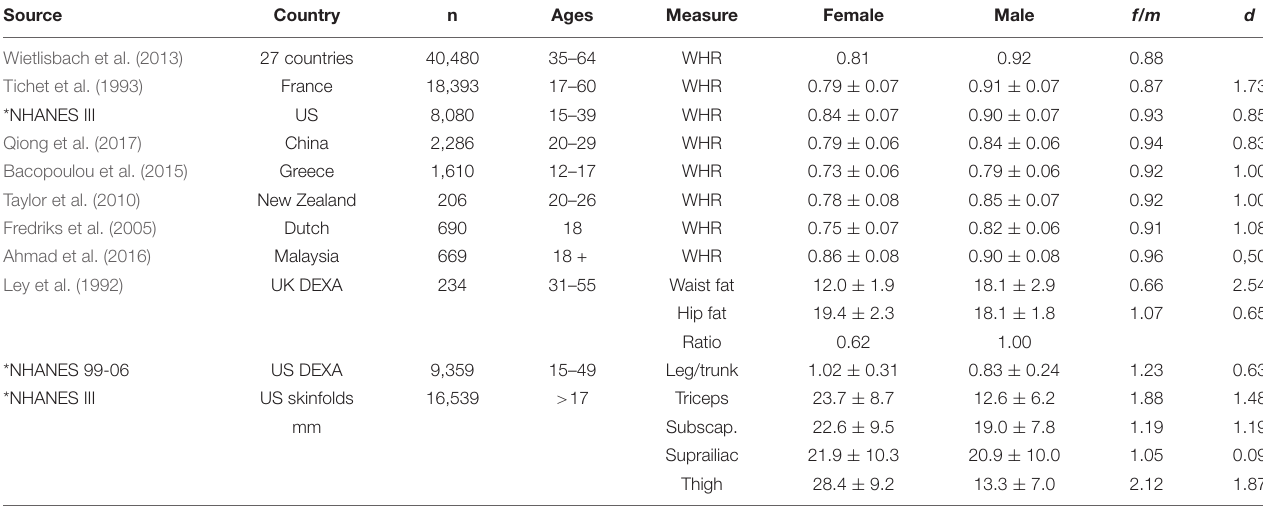
TABLE 3 | Sex differences in waist-hip ratio (WHR) and other measures of fat distribution.